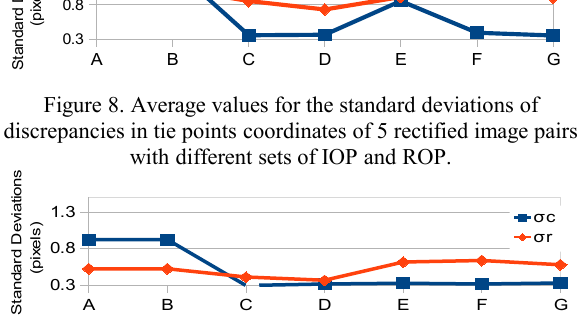
Figure 6. Standard deviations of the computed base components.